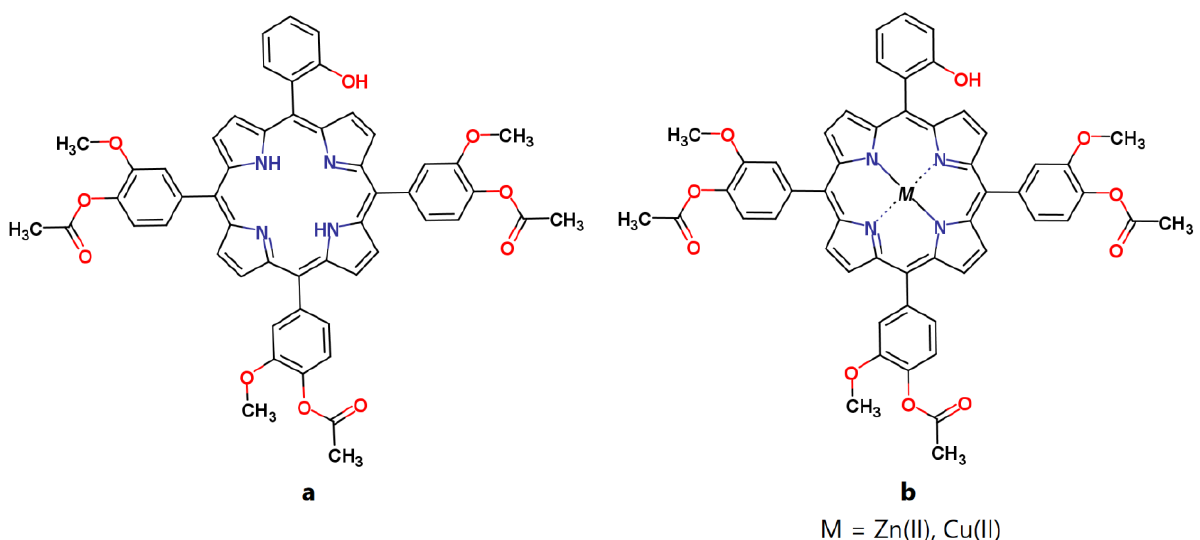
Figure 1. The molecular structures of the investigated porphyrins. ( a ) 5-(2-hydroxyphenyl)-10,15,20-tris-(4-acetoxy-3-methoxyphenyl) porphyrin, ( b ) 5-(2-hydroxyphenyl)-10,15,20-tris-(4-acetoxy-3-methoxyphenyl)porphyrinatozinc(II), 5-(2-hydroxyphenyl)-10,15,20–tris-(4-acetoxy-3-methoxyphenyl)porphyrinatocopper(II).